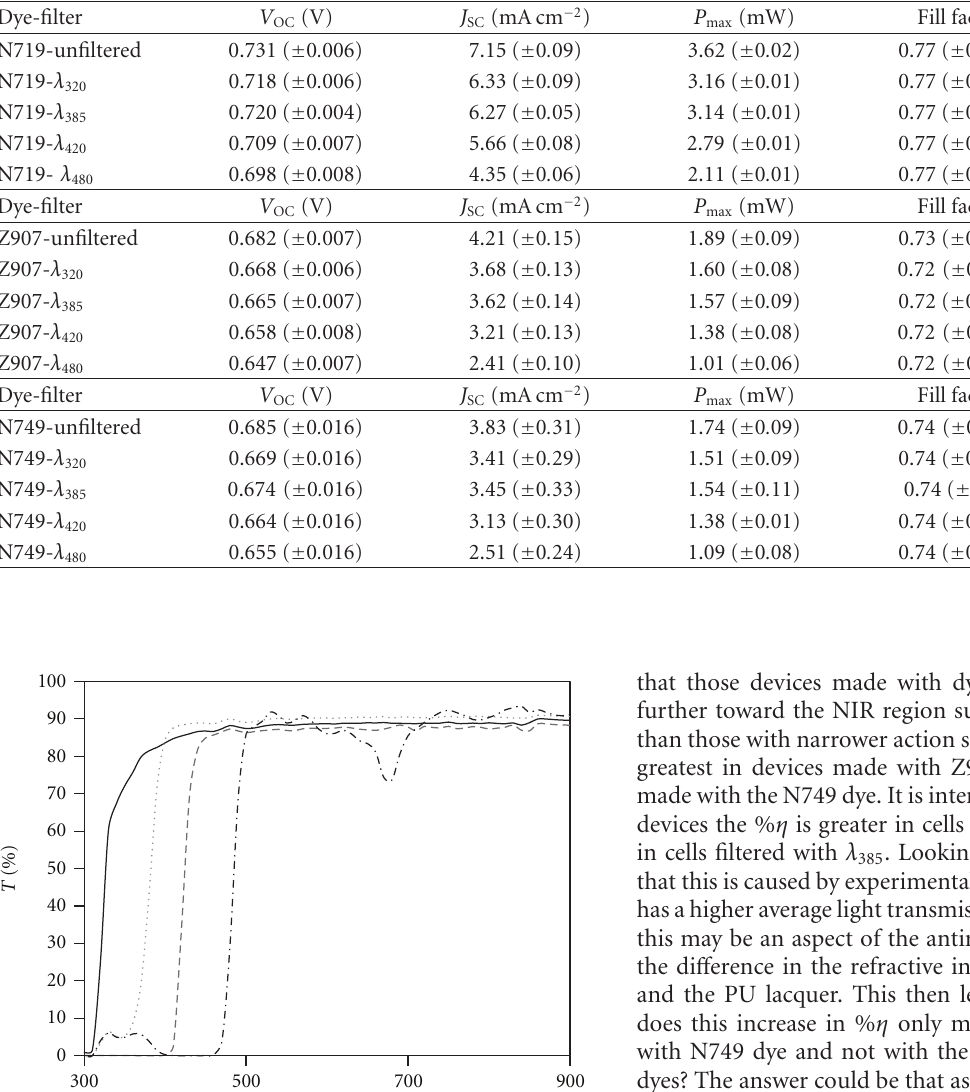
Table 3: Summary of I - V data for filtered and unfiltered, forward illuminated cells.